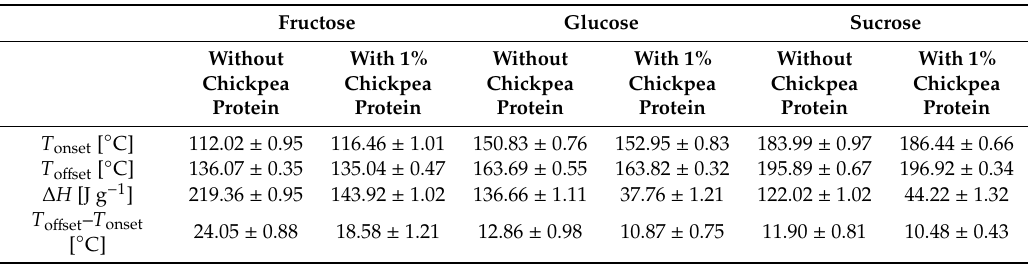
Table 3. E ff ects of chickpea protein preparation on thermal changes occurring in reducing sugars and sucrose during